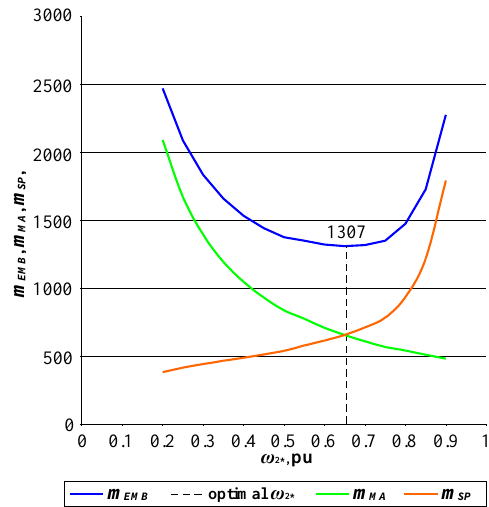
Fig. 1. EMB, electrical machine and flywheel mass curves without rotor kinetic energy, discharge process duration 5 seconds.